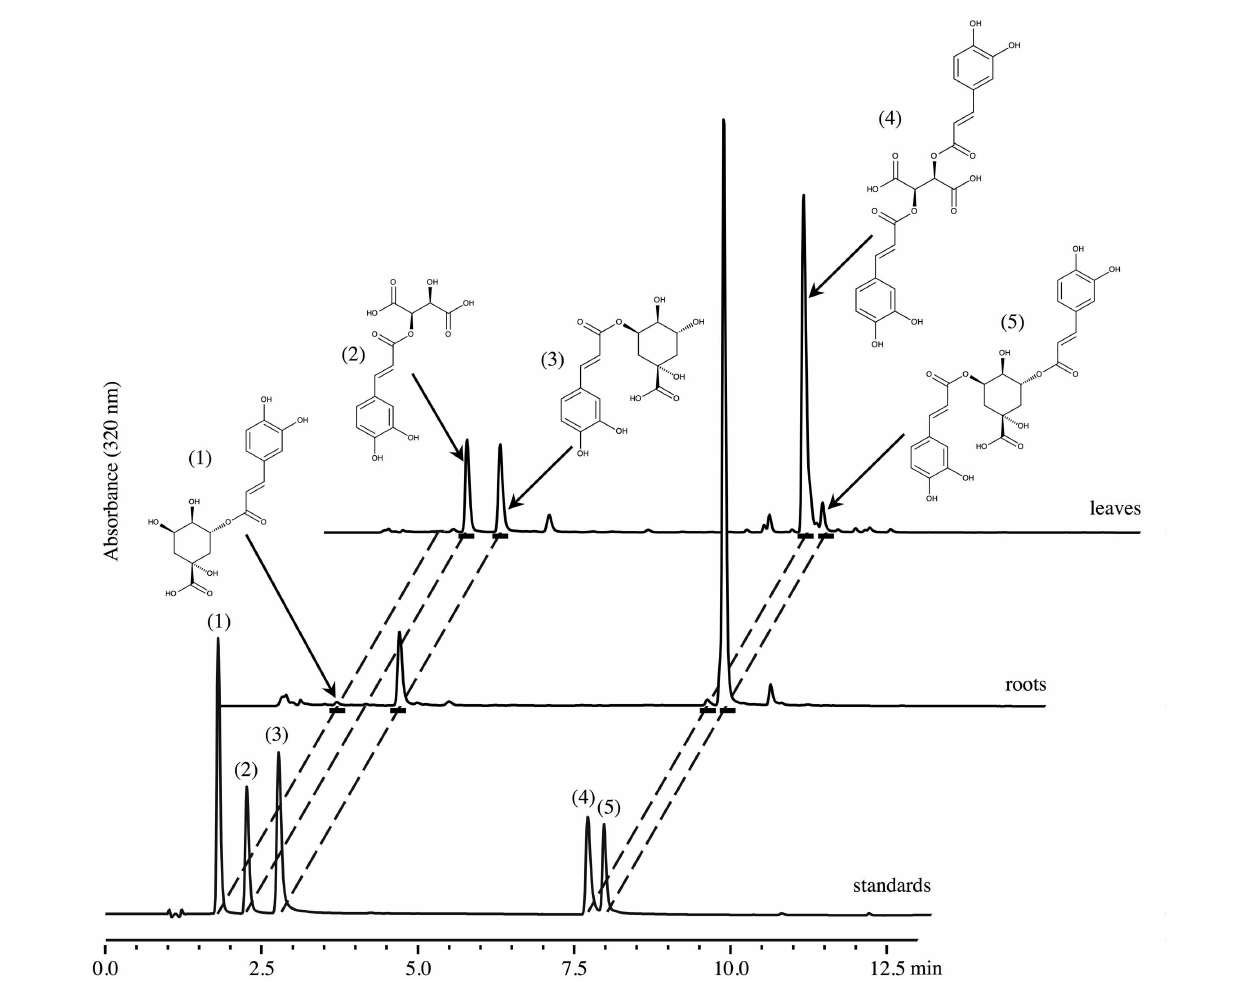
FIGURE 2 | Chromatograms of crude methanolic extracts from leaves and roots of chicory seedlings and of a standard mixture. Products were characterized by their retention times and UV absorbance spectra recorded with a photodiode array detector. Standards: (1) neochlorogenic acid, 5-CQA; (2) caftaric acid; (3) chlorogenic acid, 3-CQA; (4) chicoric acid; (5) isochlorogenic acid, 3,5-diCQA.